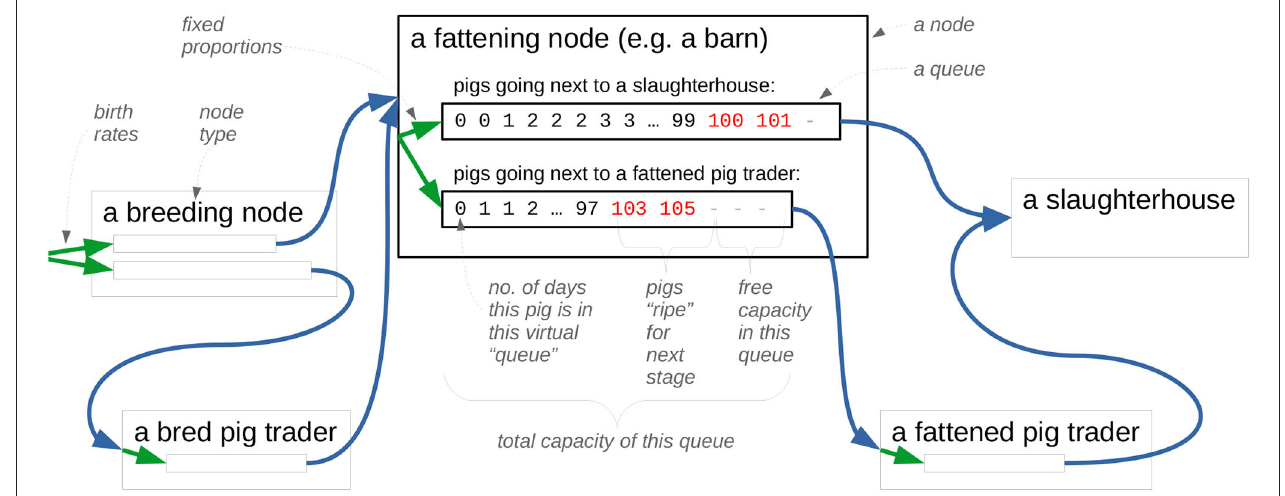
FIGURE 3 | Logic of the random animal trade transmission network model, here for the simple model of German pig trade used in this